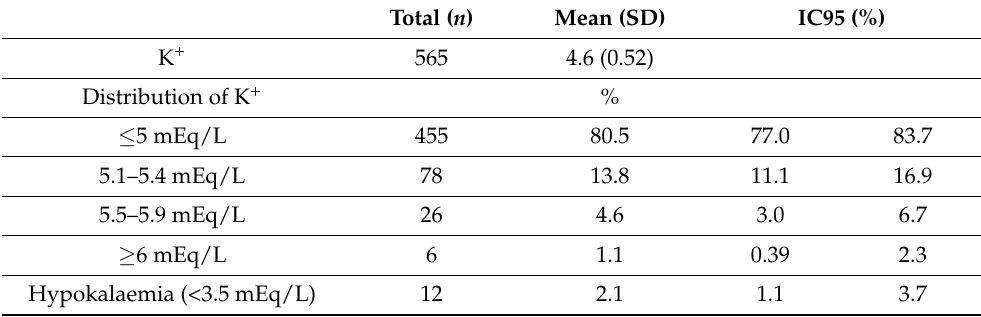
Table 3. Distribution of K + values and prevalence of hyper- and hypokalaemia at the baseline